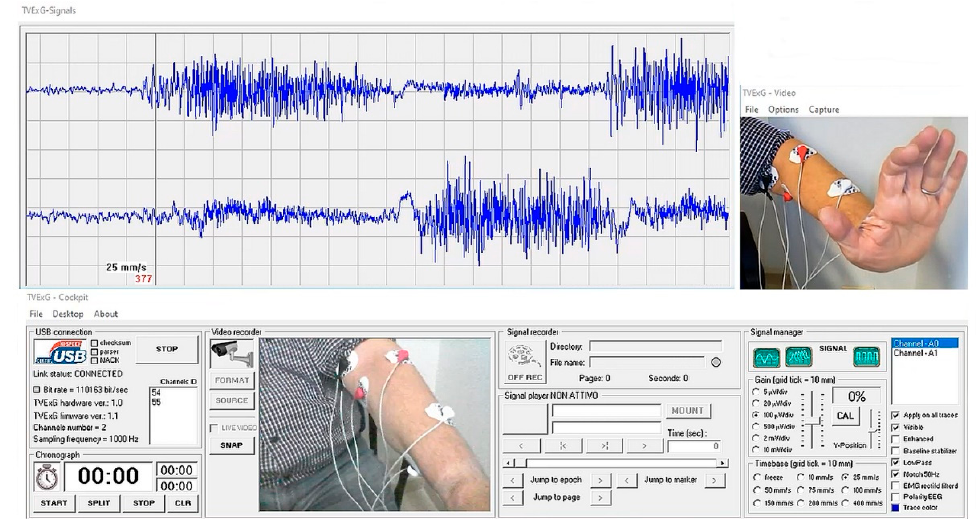
Figure 8. A screenshot of the signals coming from the built device. Images of the movement can be recorded synchronously with the tracings.